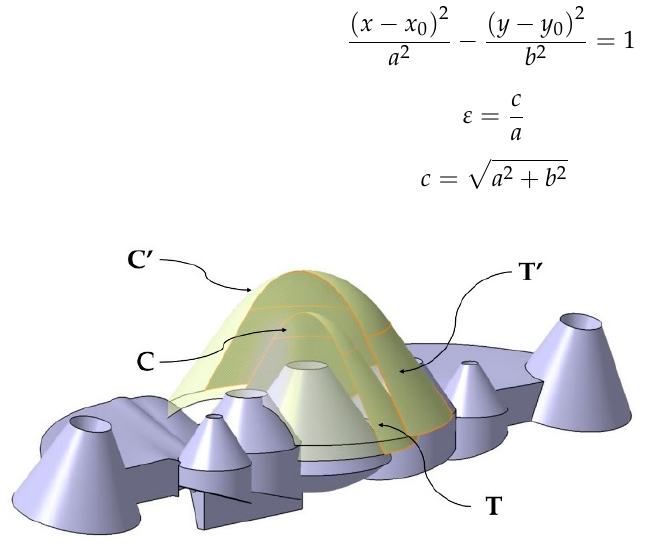
Figure 4. Truncated conical surfaces T, T ’and spherical domes C, C’.